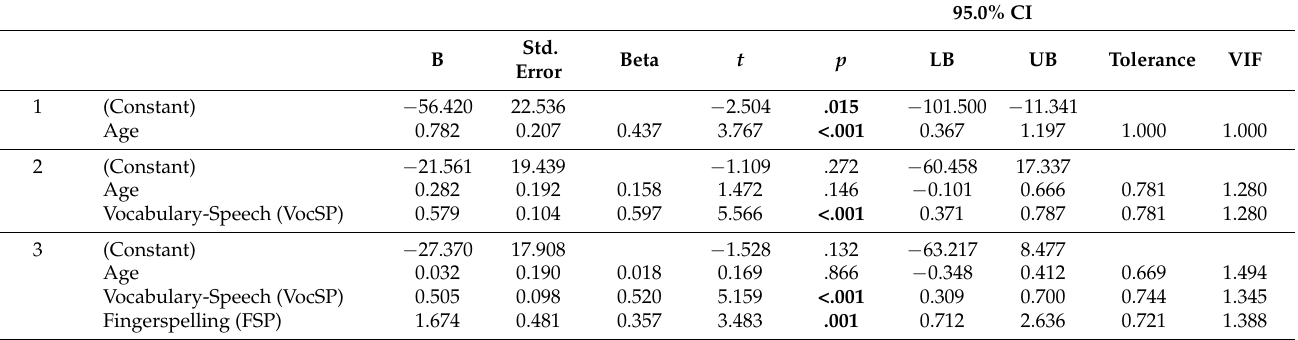
Table 8. Regression coefficients for text fluency at T2. Significant predictors are